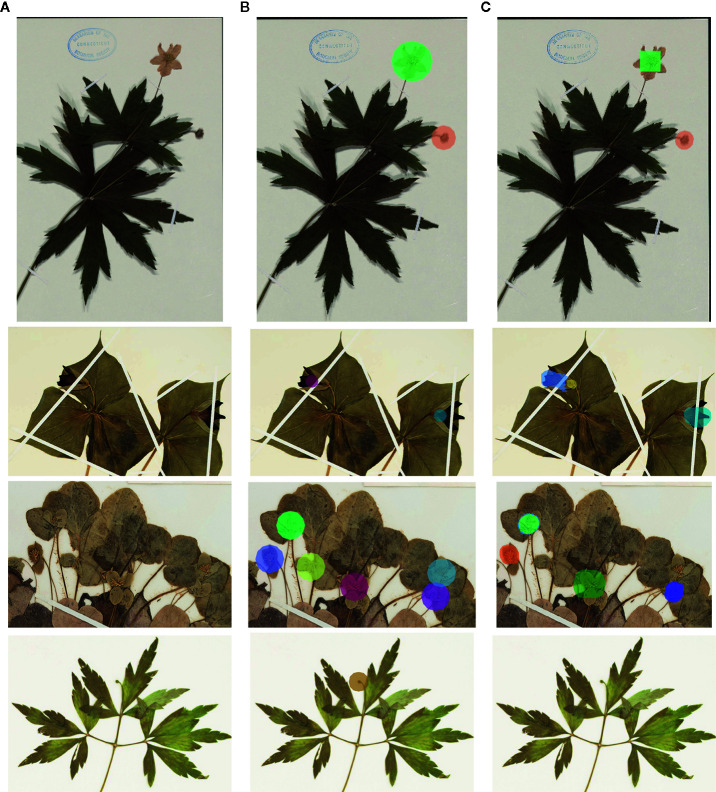
Examples of detection (colors do not have a particular meaning)—(A) original image; (B): ground-truth markers; (C): automatically detected masks. The first row corresponds to a typical case with a perfect count. The second row corresponds to a case of over-estimated counts (one of the flowers was detected as two flowers). The last two rows correspond to under-estimated.